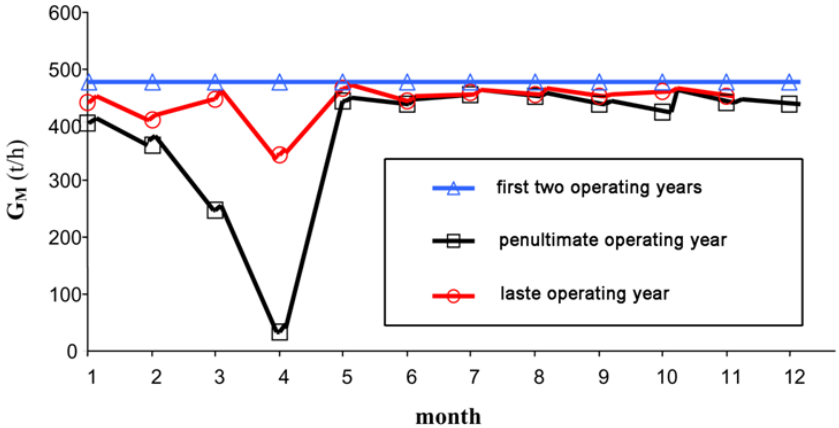
Figure 3: Comparison of crude blending mass rate v.s. the